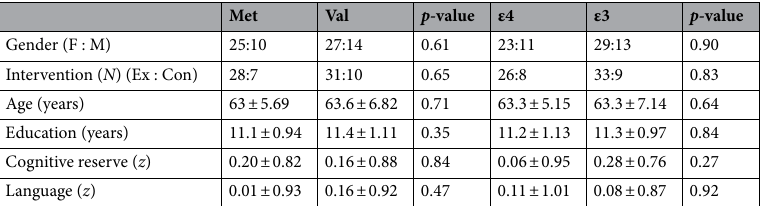
Table 1. Seventy-six participants characteristics expressed as mean (M) ± standard deviation (SD) unless otherwise noted. Data represented are mean values ( SD ) for continuous variables and proportions for categorical variables. Met and Val relate to participants with specific BDNF Val66Met polymorphisms. ε4 + and ε4- refer to participants of the APOE polymorphism. F = female; M = male; Ex = Experimental; Con = Controls; z = z